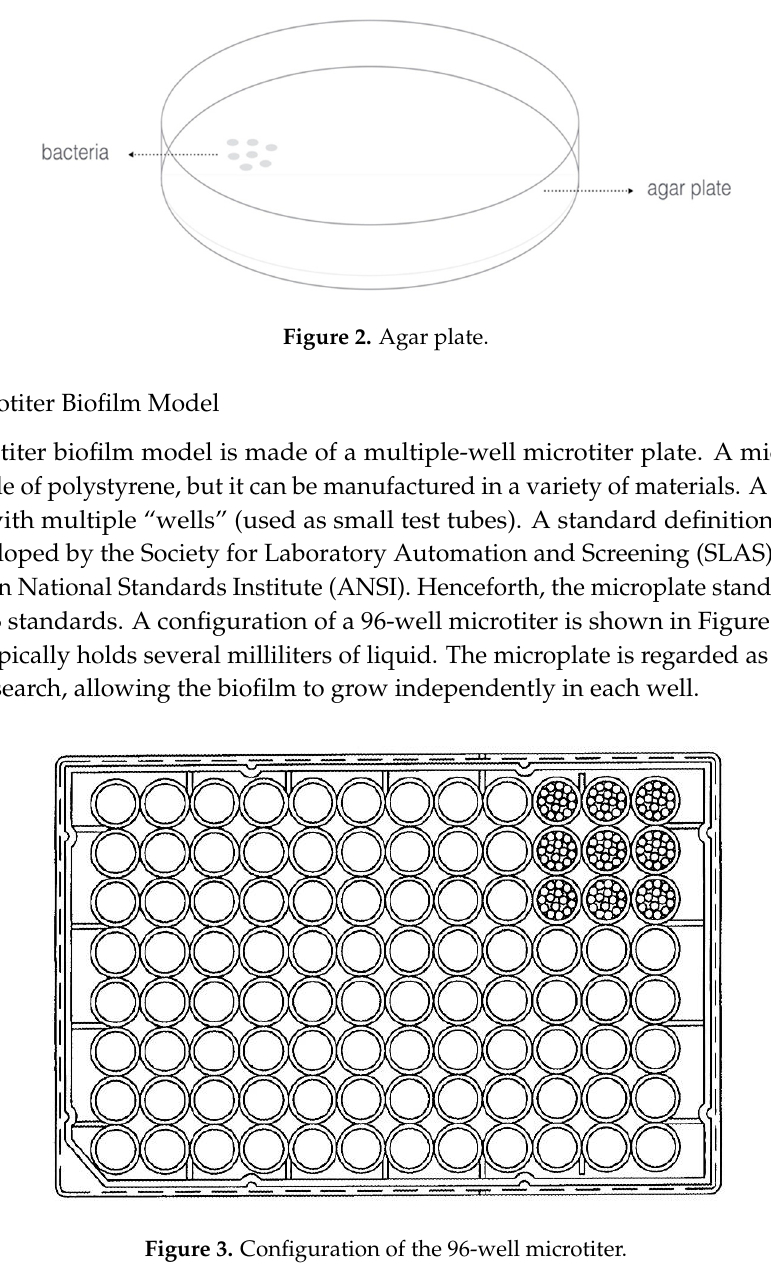
Figure 3. Configuration of the 96-well microtiter.